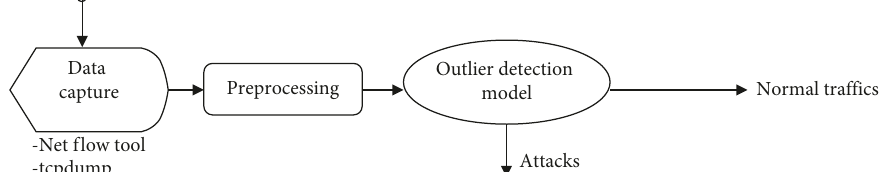
Figure 2: A general model for outlier detection in IDS.